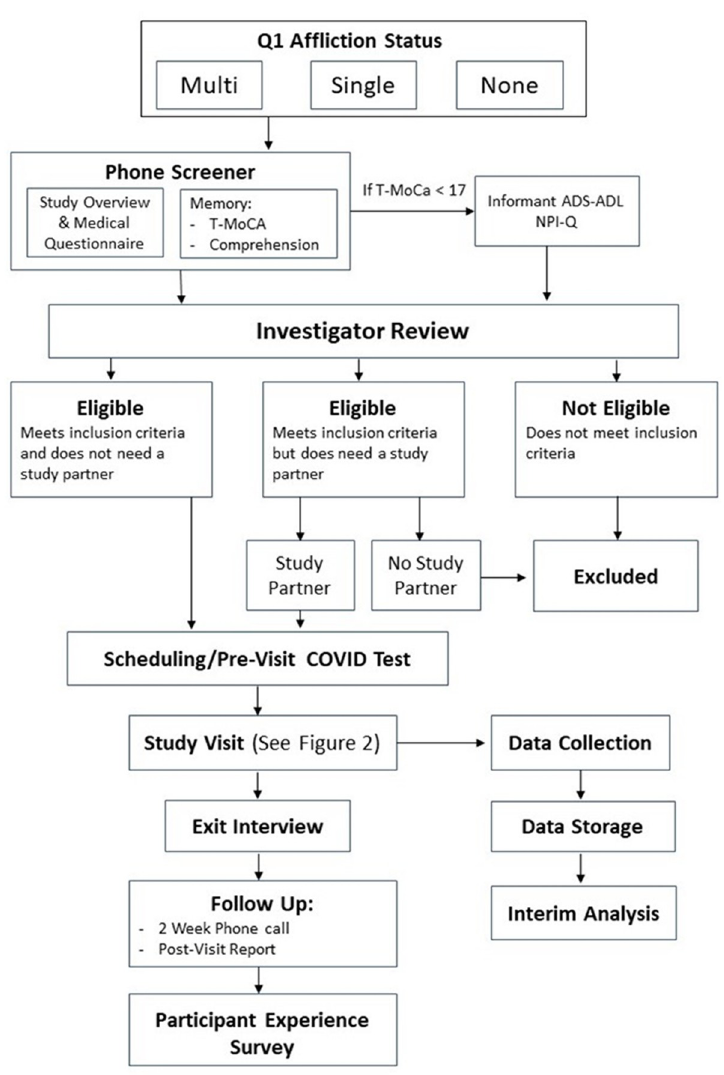
Fig 1. Flow diagram depicting study design of the Football Players Health Study’s In-Person